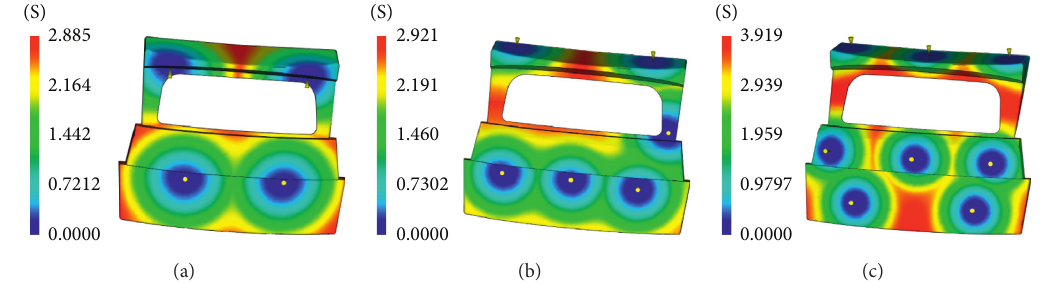
Figure 5: Filling time with (a) four gates, (b) six gates, and (c) eight gates.